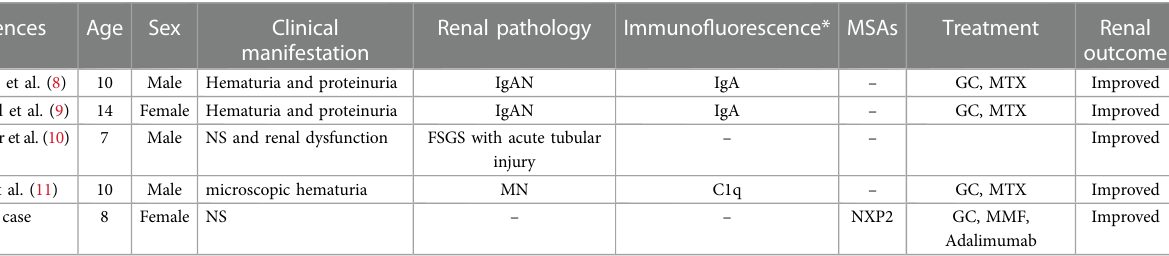
TABLE 2 Summary of the case reports of JDM with renal